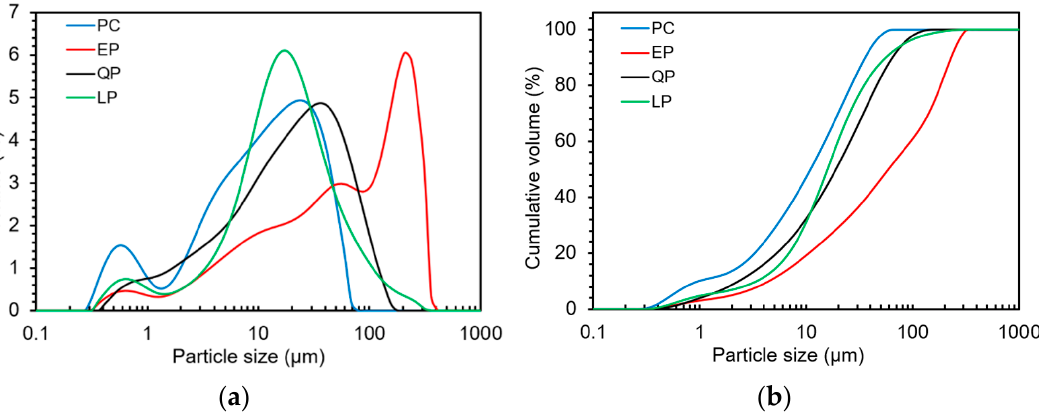
Figure 2. Volume distribution (a) and cumulative distribution (b) of particle size of EP, QP, LP and cement.